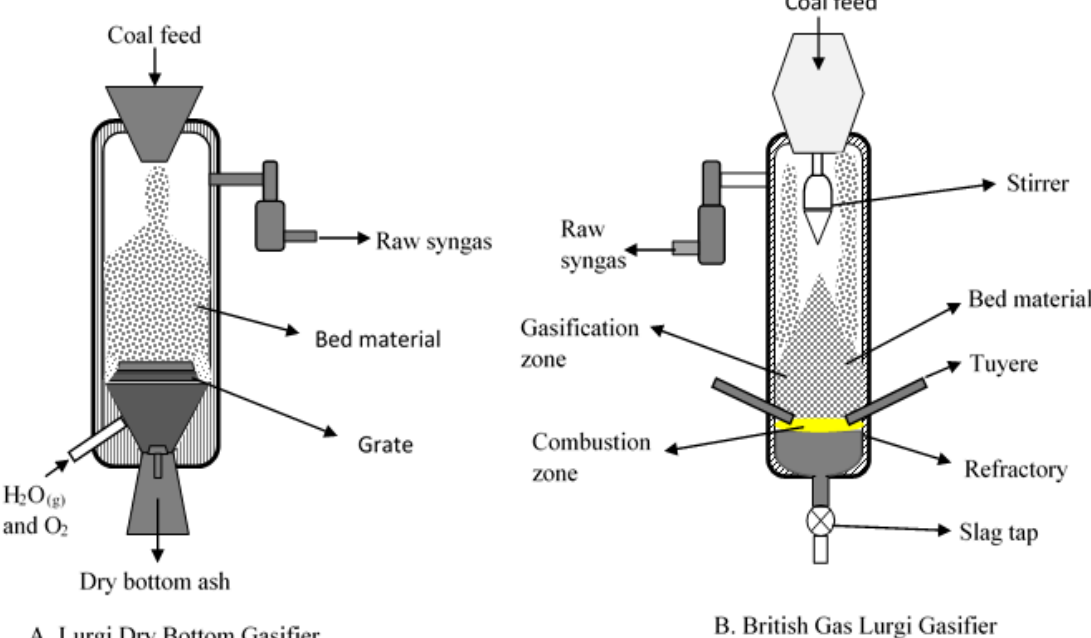
Figure 3. Schematic of fixed bed gasifiers ( A ) Sasol-Lurgi Dry Bottom Gasifier